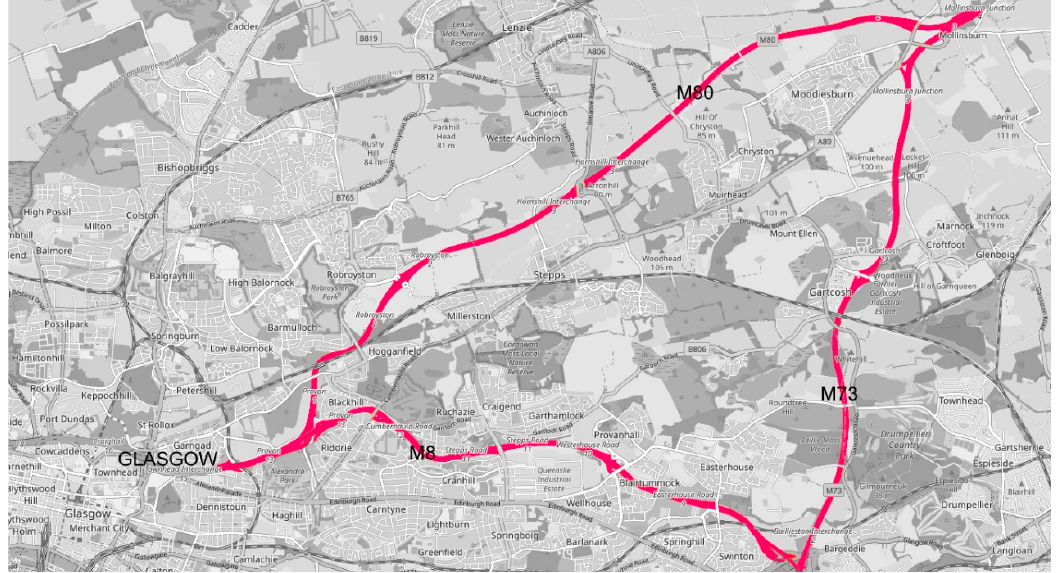
Figure 10. Section of the digital twin model of the city of Glasgow used in the VR driving simulator.